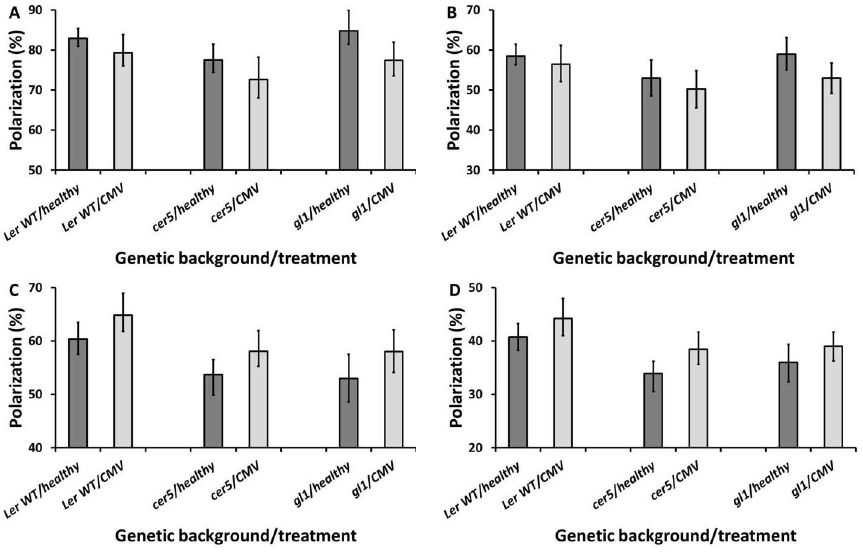
Fig 3. Average percentage polarization of light reflected from the adaxial (A,B) and abaxial (C,D) surfacesof healthy and CMV-infected L er WT, cer5 and gl1 leaves, in the blue (A,C) and green (B,D) colour channels. Error bars denote95% confidenceintervalsof the means. Imagingwas performed at 21 days post-inoculation, on systemically infected rosette